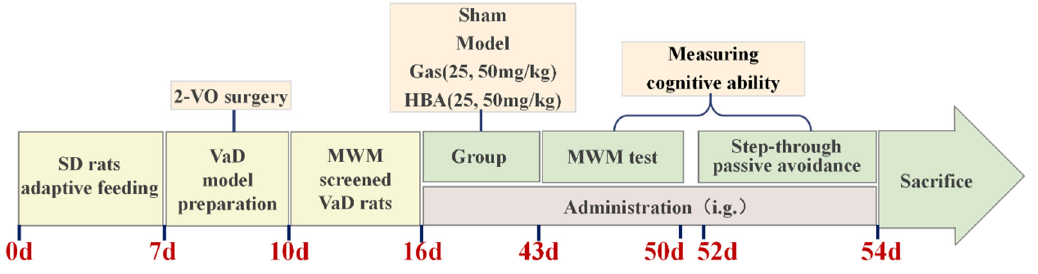
Figure 7. Schematic description of the potential effects of Gas and HBA on energy metabolism and mitochondrial function in VD rats. ( A ) Brain energy supply was impaired in VD rats; ( B ) Gas and HBA regulate brain energy supply in VD rats. Red indicates upregulation, blue indicates downregulation, and * indicates that only Gas has a regulatory effect.